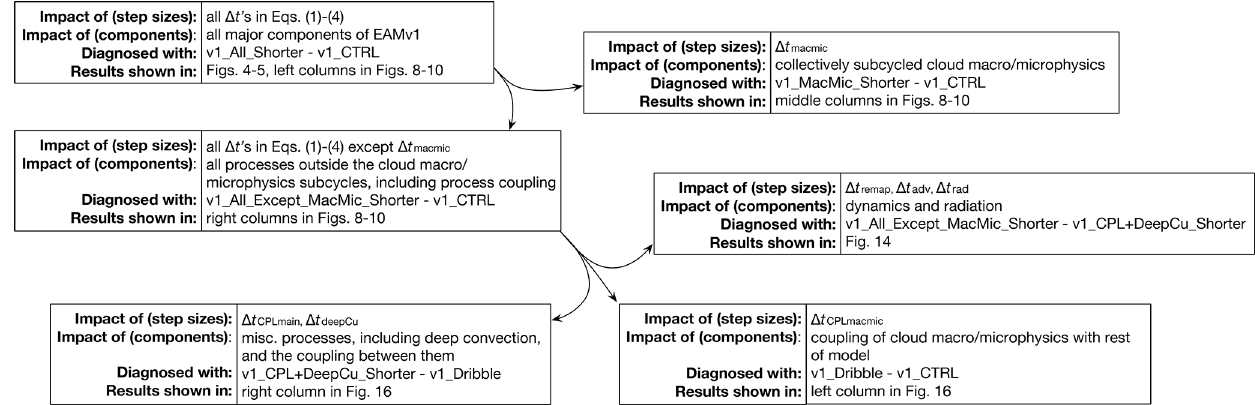
Figure 3. A schematic explaining the attribution of time step sensitivities. Time step sizes used in the various simulations are summarized in Tables 1 and A1 and depicted in Figs. 2, 7, 13, and